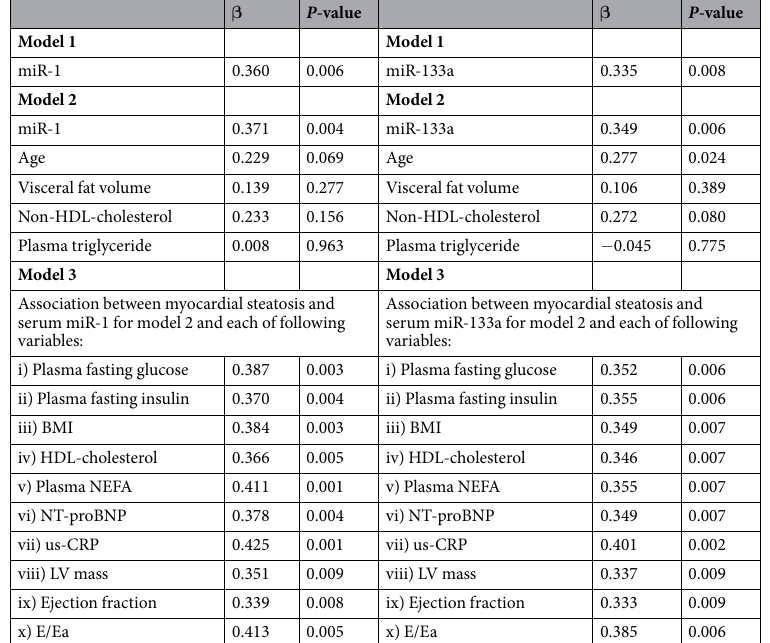
Table 3. Association between myocardial steatosis and serum cardiomyocyte-enriched miRNA in patients with uncomplicated type 2 diabetes. Data are expressed as standardized beta ( β